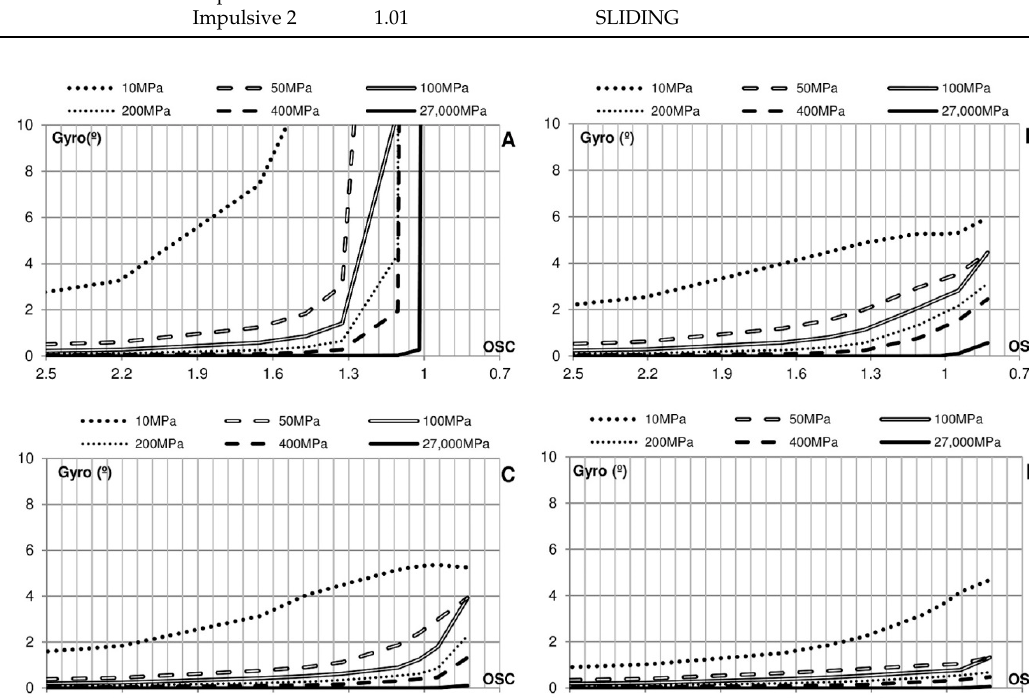
Figure 22. Crown wall rotation as a function of OSC and the shape of the signal, assuming elastic soil ( A ) E (MPa) = 10; ( B ) E (MPa) = 100; ( C ); E (MPa) = 27,000. In Figure 23, the deformation of the foundation related to the bearing capacity safety coefficient (BCSC) is presented. For the four signal shapes and the two types of soils (elastic and elasto-plastic) studied, it can be seen that in the case of permanent load (static calculation), the maximum deformation of the foundation exceeds the maximum acceptable defined value for BCSC; i.e., greater than 1.0. Only in the case of E (MPa) = 27,000 (concrete), the maximum allowed deformation is not exceeded, even with safety coefficients close to 0.0. In this case, the section fails due to rigid overturning, not plastic. In impulsive loads with a bearing capacity safety coefficient lower than 1.0, the maximum acceptable deformation is not exceeded. On the right side of Figure 23, the deformations for elasto-plastic soils are presented, showing larger deformations than in the case of elastic soil.